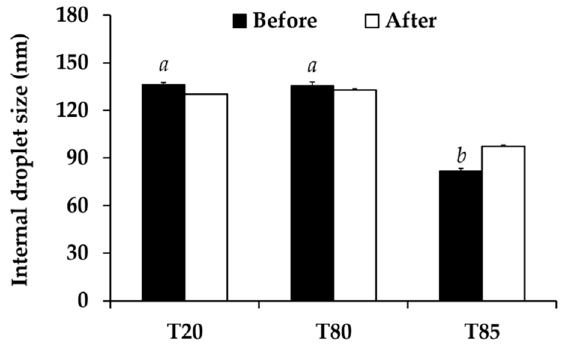
Figure 7. Internal droplet size of nanoemulsions generated using various types of surfactant, including Tween ® 20 (T20), Tween ® 80 (T80), and Tween ® 85 (T85), before and after 8 cycles of heating-cooling condition. The letters a and b denoted significant difference between nanoemulsions analyzed using post-hock Tukey ANOVA ( p < 0.05).